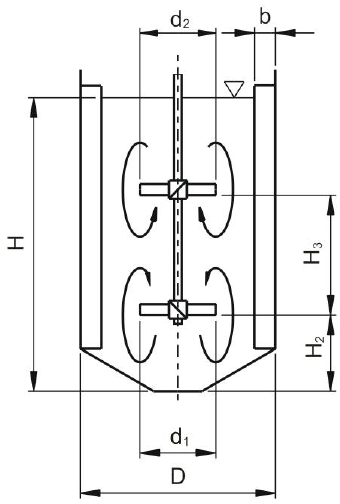
Figure 17. Recommended mixing equipment configuration for formation and homogenization of heterogeneous suspensions ( H 2 = max. d 1 , H 3 = max. d 2 ) [38].